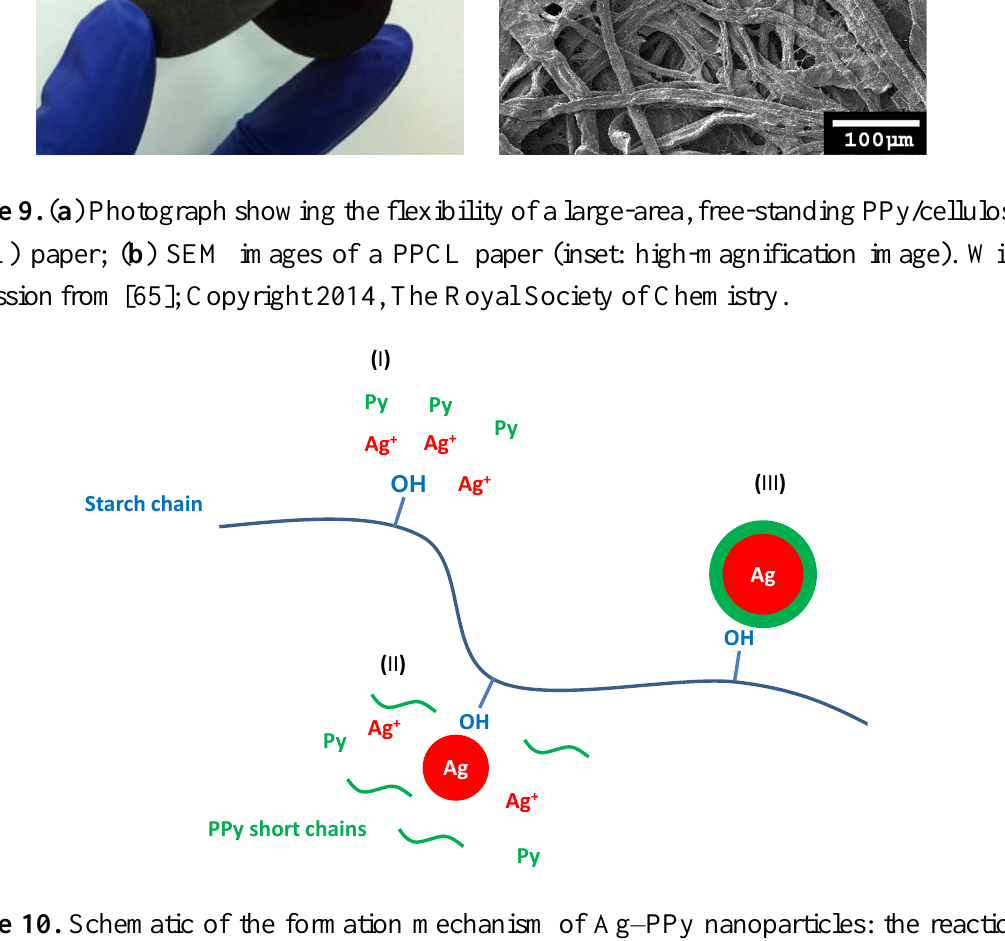
Figure 10. Schematic of the formation mechanism of Ag–PPy nanoparticles: the reaction process consisted of three stages (I, II, and III). With permission from [67]; Copyright 2012, American Chemical